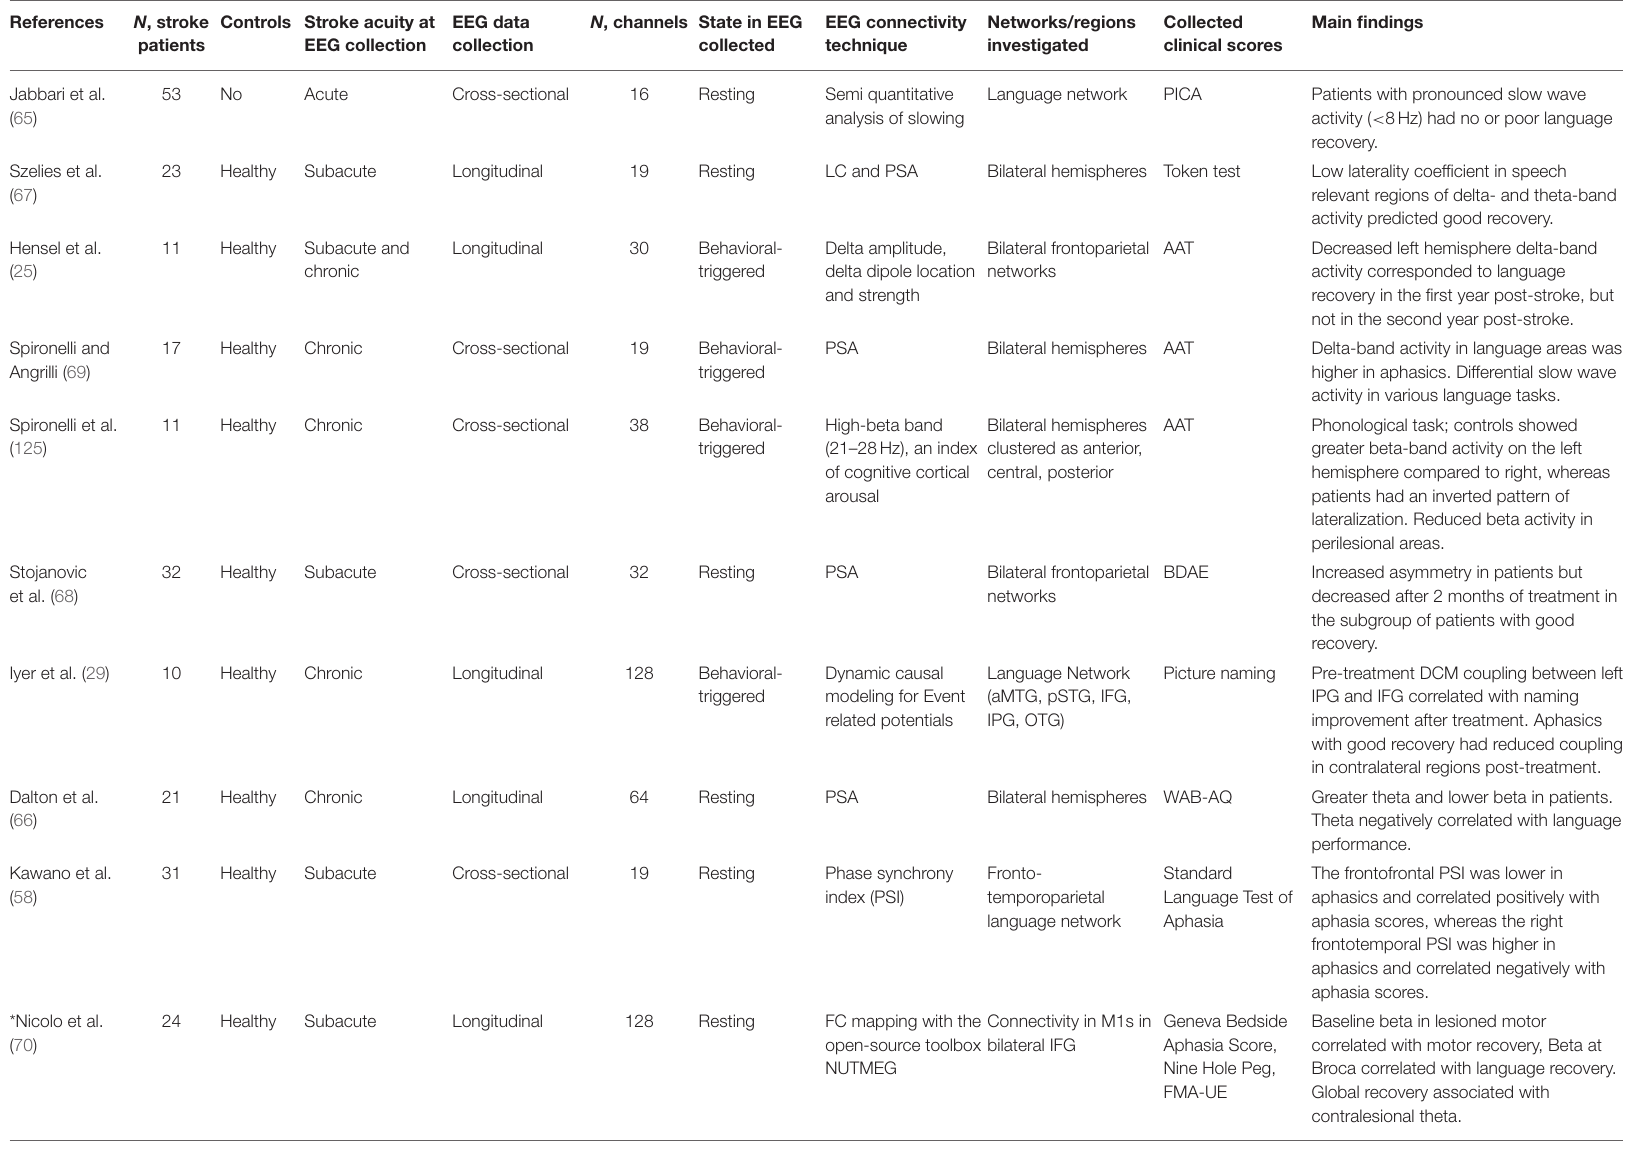
TABLE 2 | EEG language